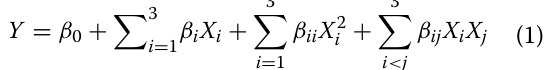
Table S1:Level of independent variables used in Box- Behnken design) were applied to the ultrasonic homog- enizer to determine responses toward minimum particle size obtained, maximum crystallinity, and good thermal properties of the GAP waste after the treatment process. A total of 17 runs of randomly ordered experiments with 5 replications at the center point were performed and shown in Table 1.